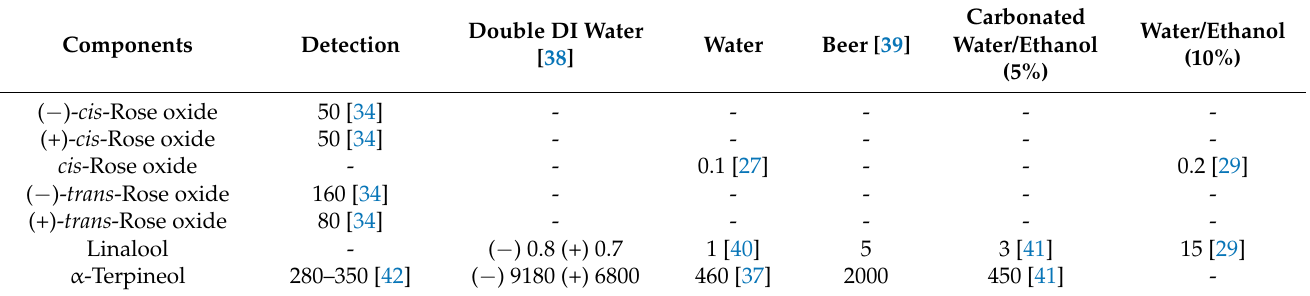
Table 4. Thresholds of Rose oxide enantiomers, Linalool and α -Terpineol in different conditions.